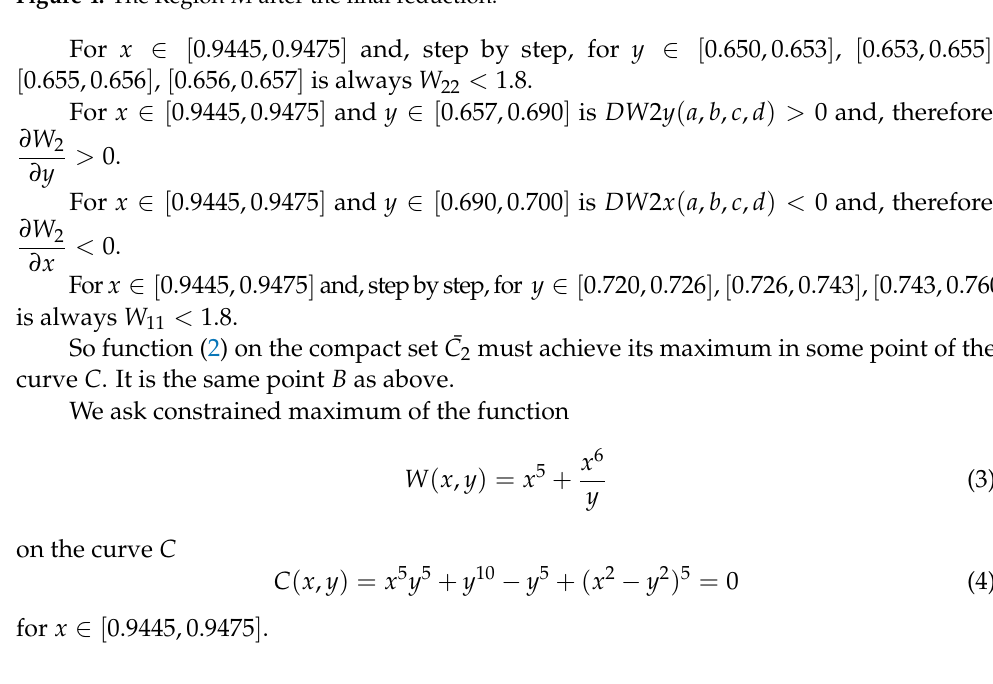
Figure 4. The Region M after the final